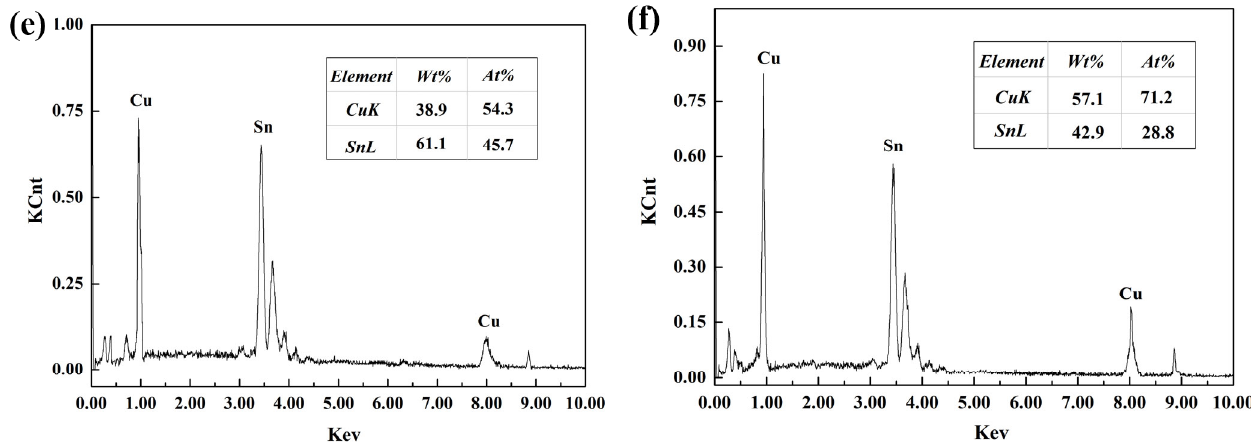
Figure 4. Interfacial microstructure of SAC105/Cu solder joint subjected to ( a ) 100 cycle; ( b ) 400 cycle; ( c ) 800 cycle; ( d ) 1000 cycle; ( e ) EDS analysis of area A in ( d ); ( f ) EDS analysis of point B in ( d ).